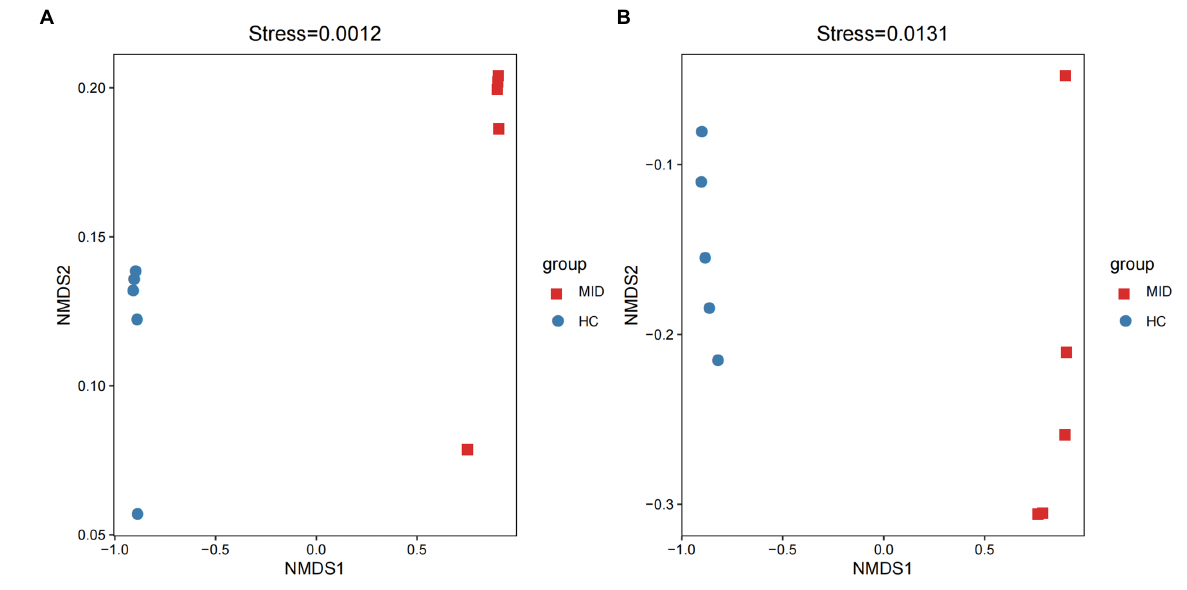
pathogenic bacteria infected the body resulting in some